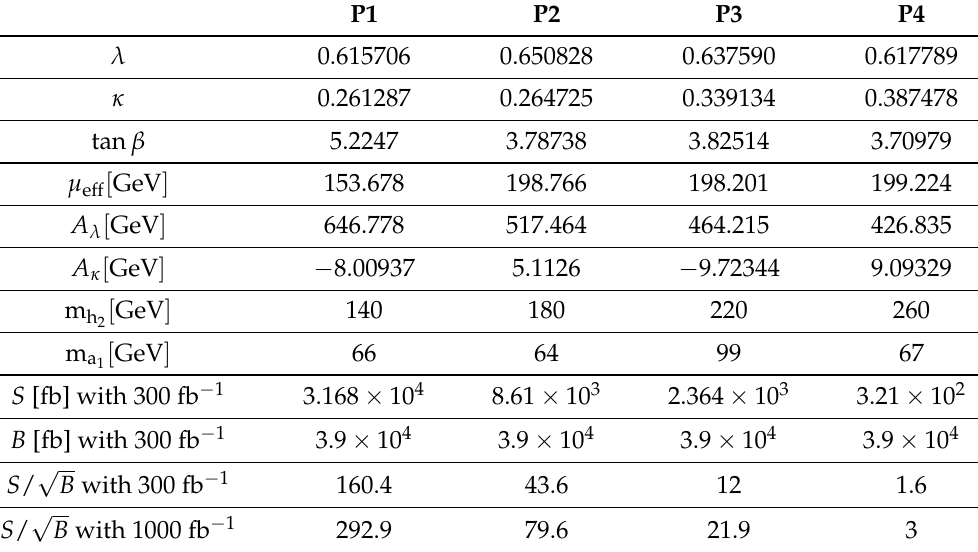
Figure 10. The production rates σ ( gg → h 2 ) .BR ( h 2 → a 1 a 1 → τ + τ − τ + τ − ) ( left ) and σ ( gg → h 2 ) .BR ( h 2 → Za 1 → τ + τ − τ + τ − ) ( right ) as functions of m h [58]. 2 Table 3. The four benchmark points P1, P2, P3, and P4 used in the signal-to-backgrounds analysis